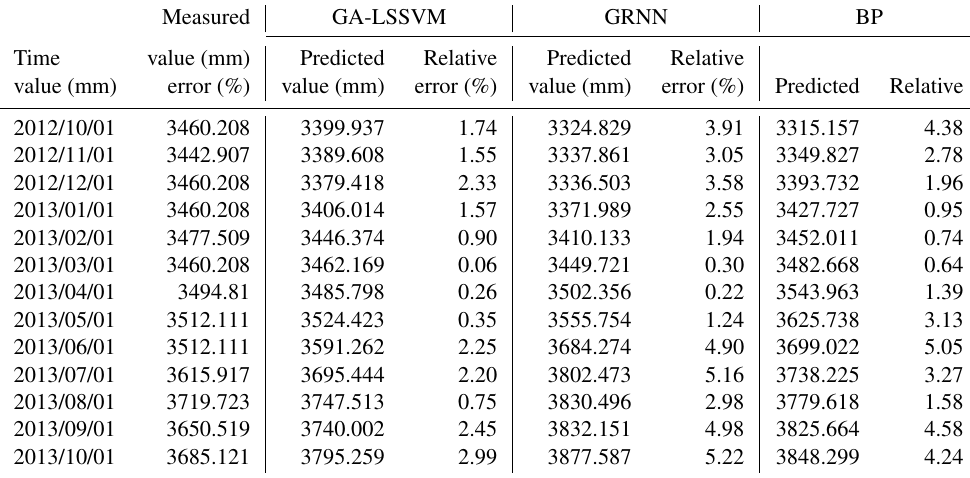
Table 4. Comparison between the predicted values of cumulative displacement and measured values at monitoring station ZG86. Measured GA-LSSVM GRNN BP Time value (mm) Predicted Relative Predicted Relative error (%) Predicted